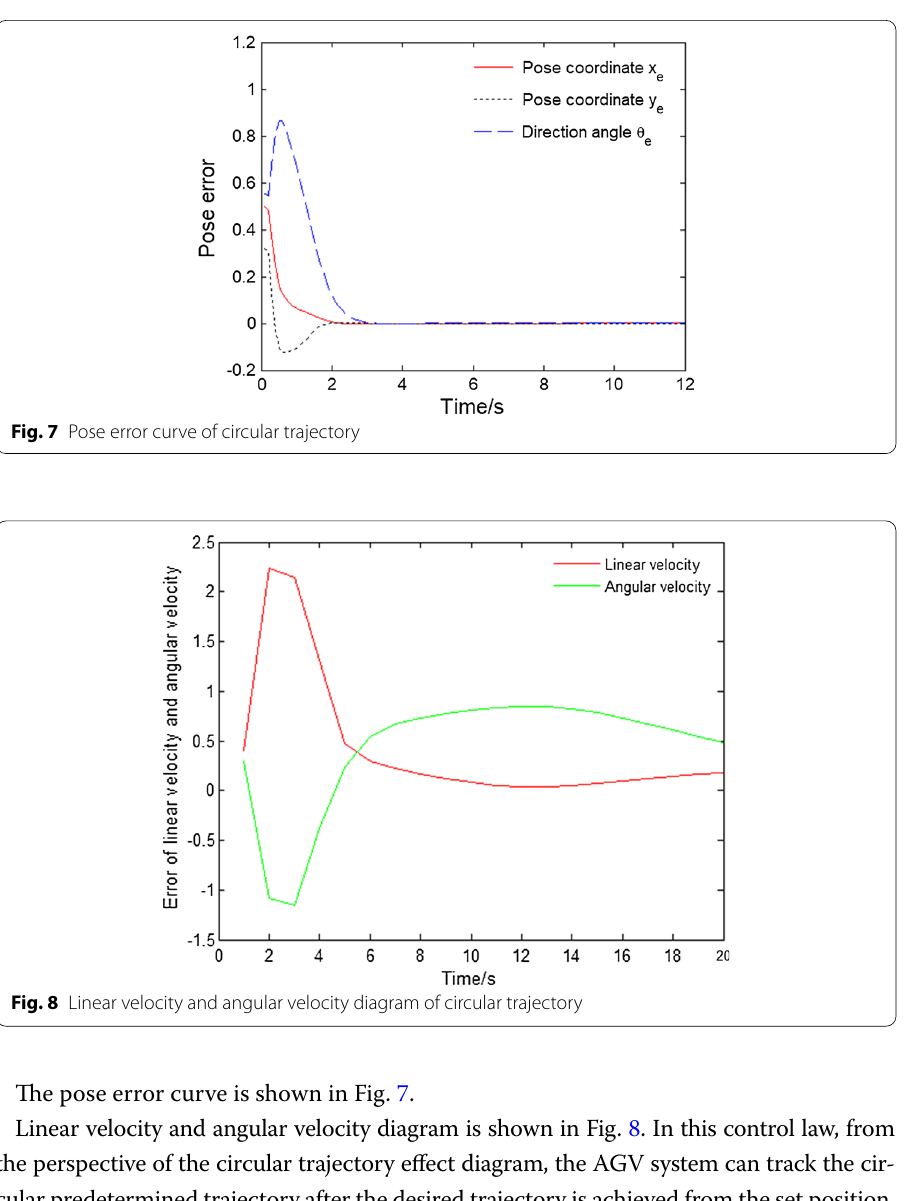
The pose error curve is shown in Fig. 7.